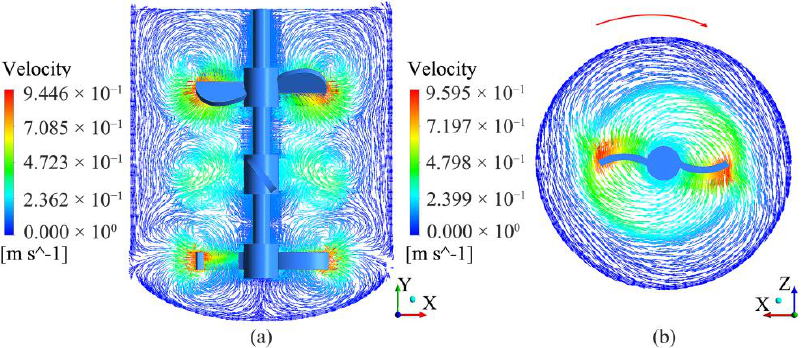
Figure 11. Velocity vector diagram when the medium is glycerin and Re = 55.5. ( a ) TBC-B type agitator, Plane 1:XY,Z = 0 mm; ( b ) TBC-B type agitator, Plane 3:XZ,Y = 70 mm.